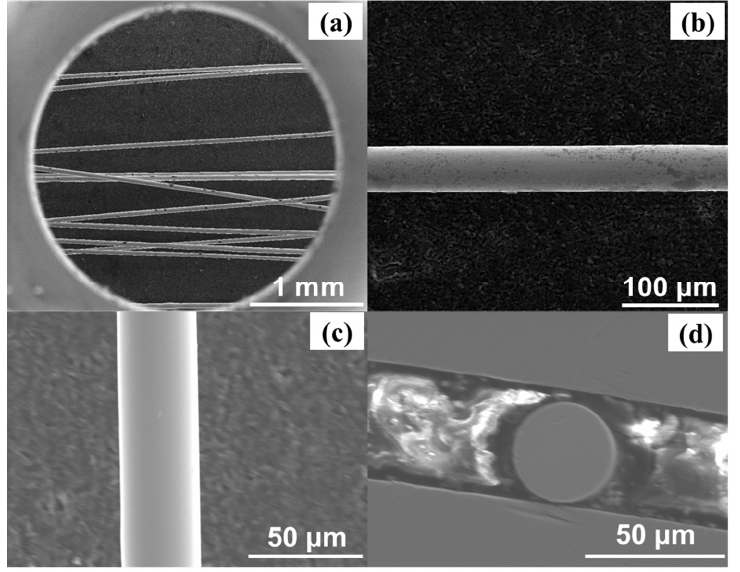
Figure 1. SEM images of AMFs. ( a ) Ni-based fibers. ( b ) The magnification of ( a ). ( c ) The magnification of Fe-based fiber and ( d ) cross-sectional image of Fe-based fiber.